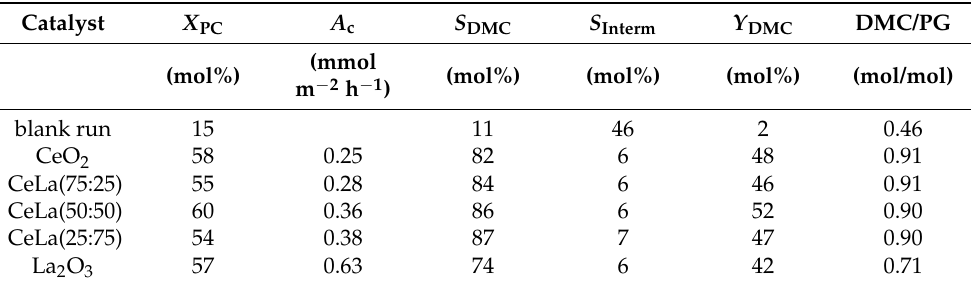
Table 3. Catalytic results for the transesterification of PC with methanol at 160 ◦ C under au- togenic pressure (15 bar). Other experimental conditions were: CH 3 OH/PC = 10 mol/mol; catalyst/PC = 0.03 g/g; reaction time = 4